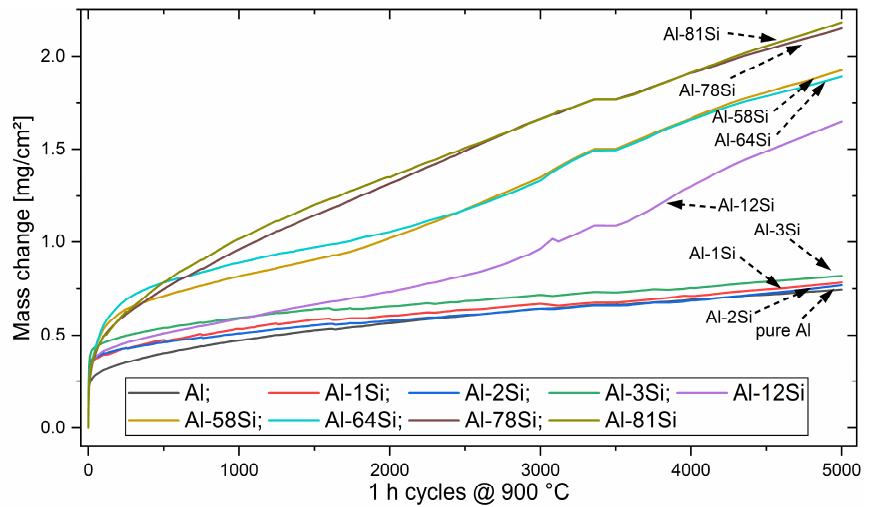
Figure 10. Mass change curves during cyclic oxidation for 5000 cycles (each 1 h) at 900 °C of TNB-V2 substrates with different Al-Si and pure Al coatings.